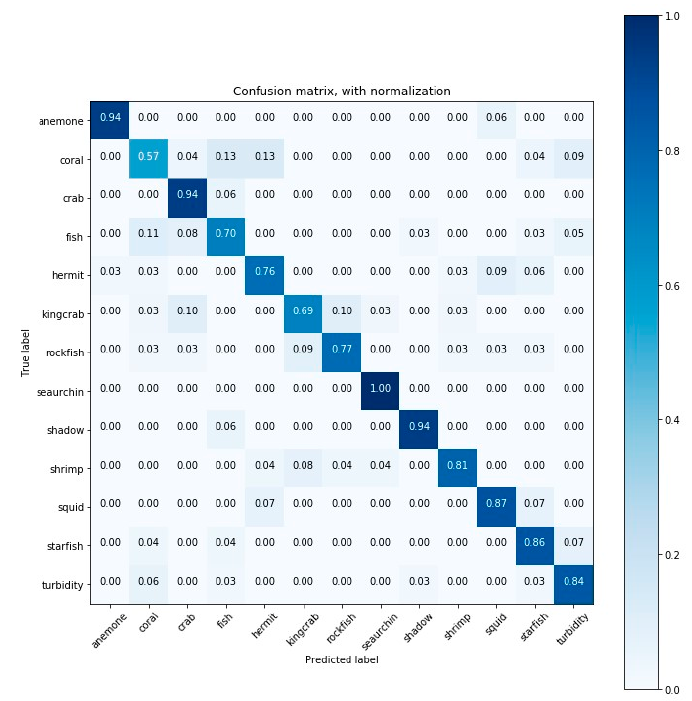
Figure A13. Confusion matrix for the classification results (accuracy) obtained by DNN-3.